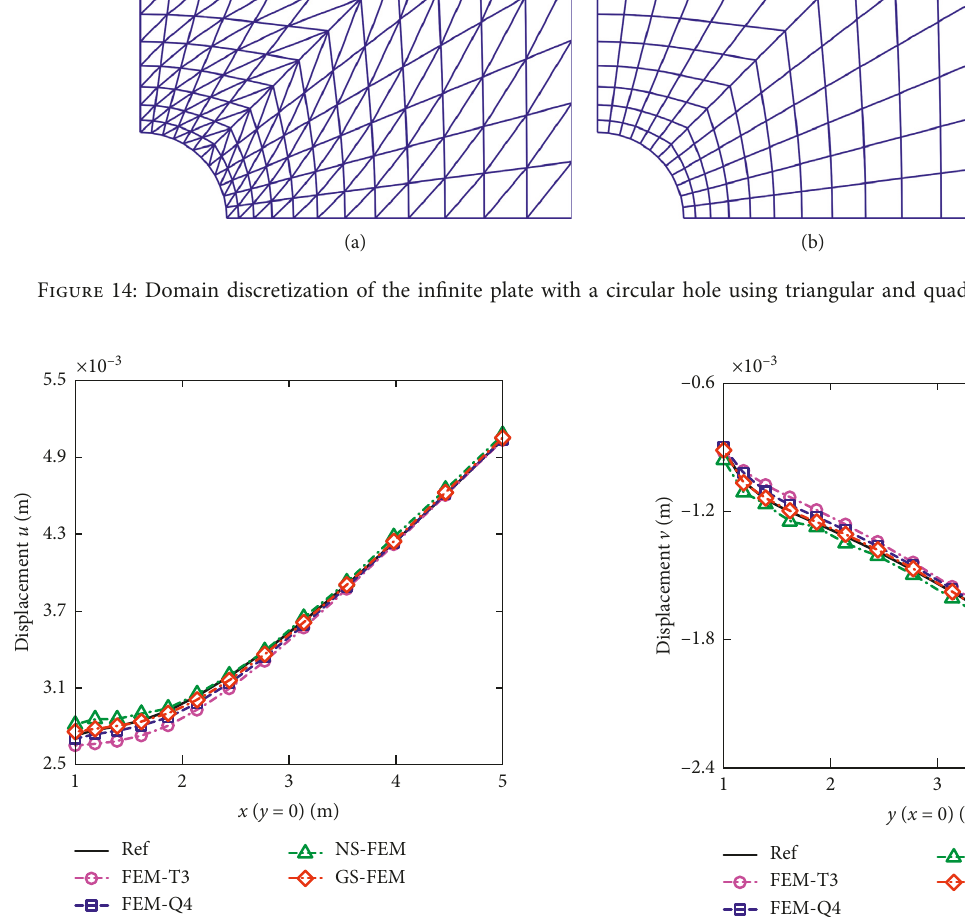
Figure 15: Displacement u along the bottom boundary. Figure 16: Displacement v along the left